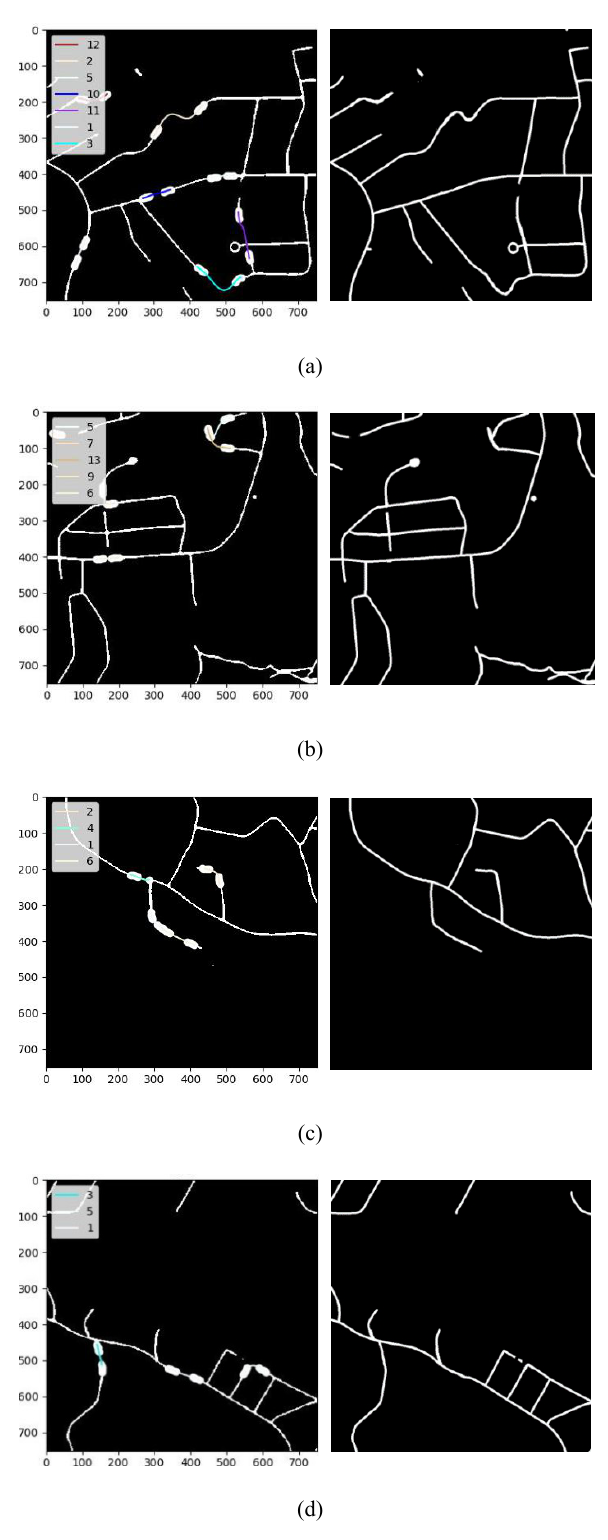
Figure 6. Road repair model and final road repair results. (a) represents the m1 road repair model and its final result. (b) represents the m2 road repair model and its final result. (c) represents the m3 road repair model and its final result. (d) represents the m4 road repair model and its final result.